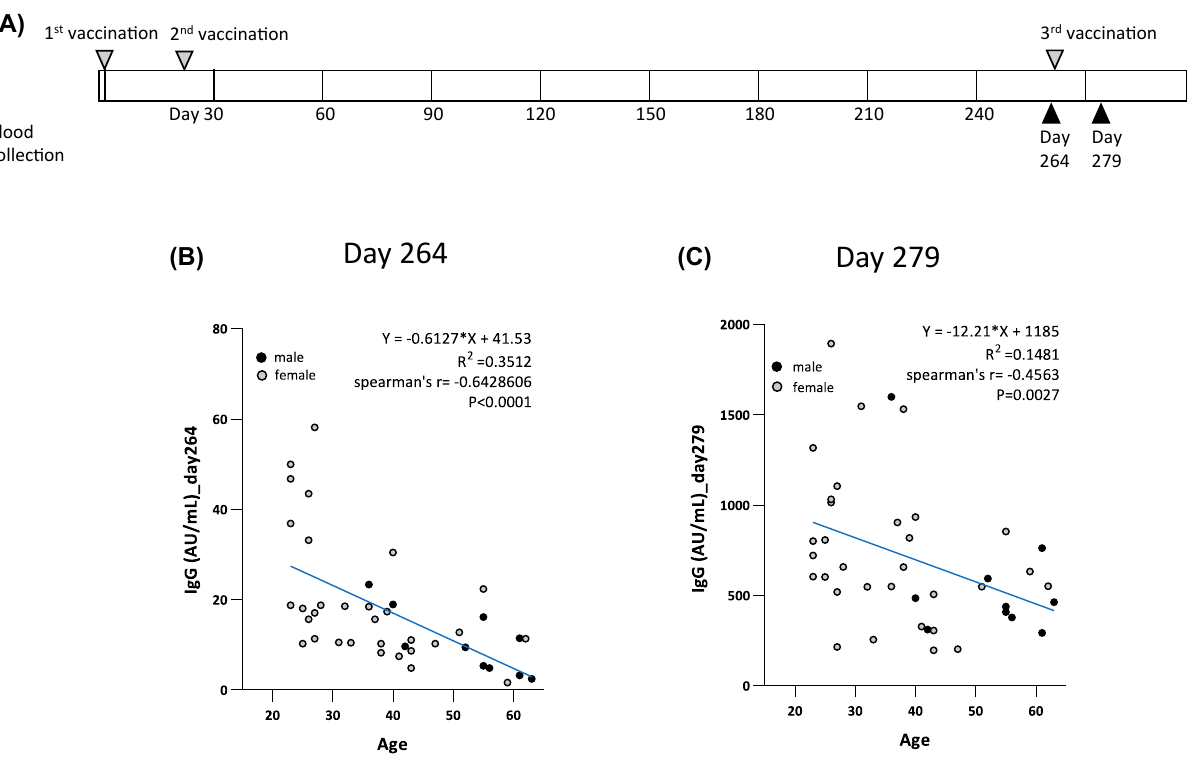
Figure 1: Vaccination procedures, sampling and anti-SARS-CoV-2 antibody levels following vaccination. (A) Schematic presentationof vaccinationand sampling procedures. Correlation of age andpost-vaccination at day 264 (B) andday 279 (C) of anti-spike IgG levels with superimposed the linear regression lines (with 95% CI). Black circles show males while gray circles show females. The statistical methods of Spearman ’ s rank correlation coef fi cient were used. p-Value is indicated. Linear regression lines, blue.